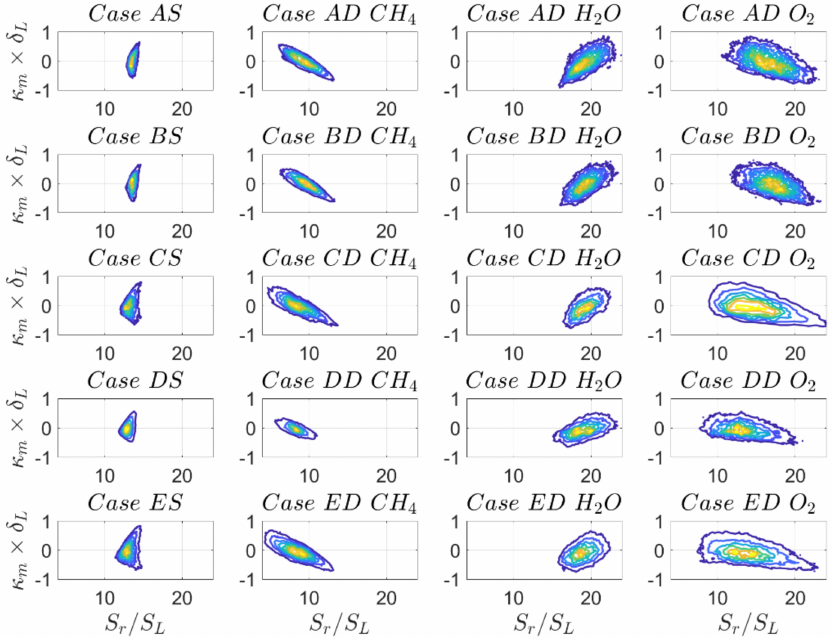
Figure 15. Joint PDF of normalised reactive component of displacement speed S r / S L and normalised mean curvature κ m × δ L on c = 0.8 progress-variable isosurface for top to bottom cases A–E for (1st column) SC and (2nd to 4th column) DC simulations for reaction progress variable based on CH 4 , H 2 O,O 2 mass fractions.